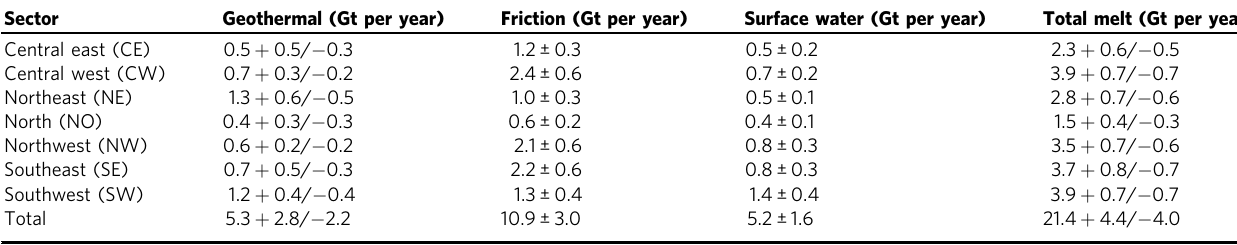
Table 1 Basal melt from the three heat terms and the total basal